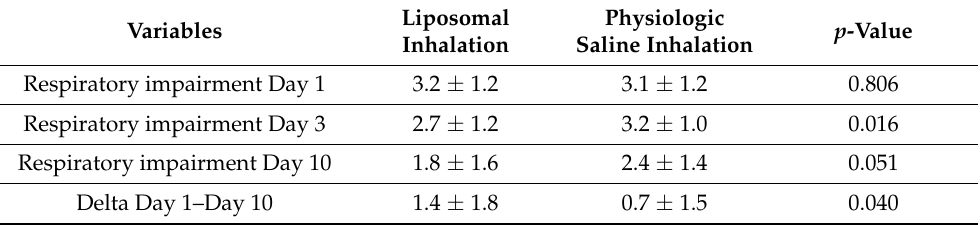
Table 3. Respiratory impairment scored by endoscopy and suction maneuvers at Day 1, Day 3 and Day 10 after tracheostomy; Respiratory impairment: sum of single values of the medical scoring system, including frequency of suction maneuver, bronchoscopical assessment and assessment of mucous congestion.